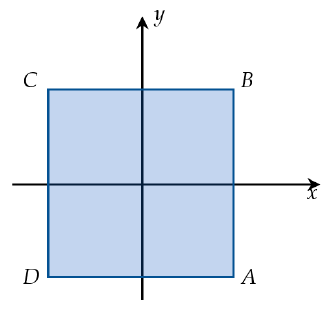
Figure 1. Square π . Table 6. The binary hyperoperation ⋆ on M .